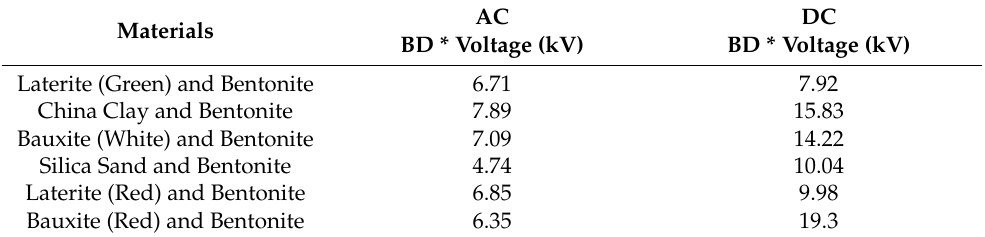
Table 5. Breakdown voltages of samples mixed with bentonite in equal proportions.